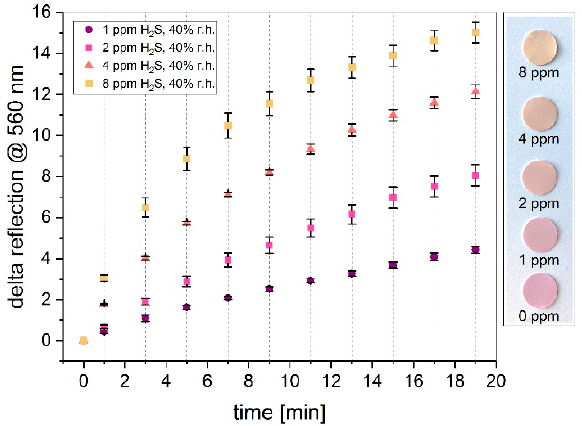
Figure 6. Delta reflection of the Cu-PAN layers printed on coated paper at a wavelength of 560 nm recorded over the measurement period. The samples were exposed to 1, 2, 4, and 8 ppm H 2 S for 20 min in synthetic air and a relative humidity of 40%.